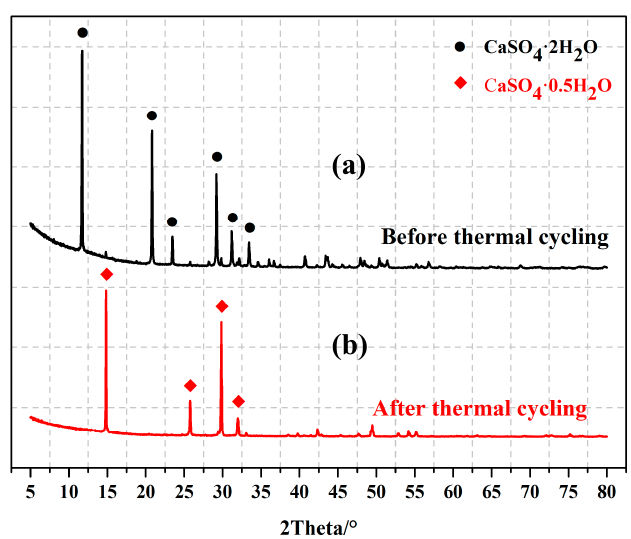
Figure 14. The XRD pattern of gypsum: ( a ) Before thermal cycling; ( b ) after thermal cycling.